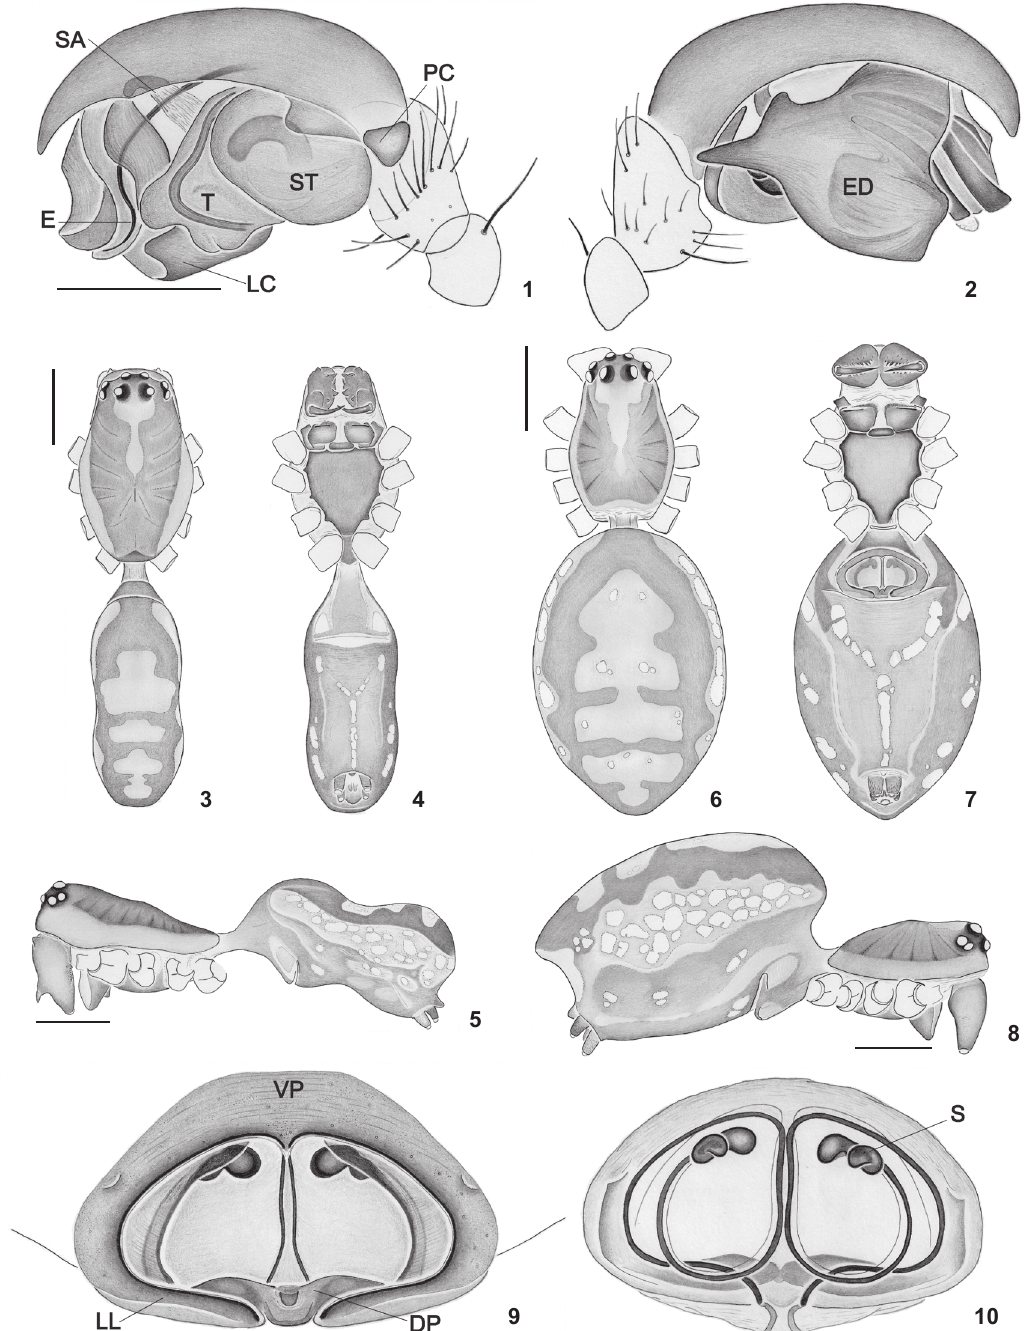
Figures 1-10. Eurymorion triunfo sp. nov. : (1-2) Male palpus: (1) ectal view, (2) mesal view; (3-5) male habitus: (3) dorsal view, (4) ventral view, (5) lateral view; (6-8) female habitus: (6) dorsal view, (7) ventral view, (8) lateral view; (9-10) female epygine: (9) ventral view, (10) dorsal view, cleared. (DP) Dorsal plate, (E) embolus, (ED) embolic division, (LC) lamella characteristica, (LL) lateral lobe, (PC) paracymbium, (SA) suprategular apophysis, (S) spermathecae, (ST) subtegulum, (T) tegulum, (VP) ventral plate. Scale lines: (1, 2, 9-10) 0,25 mm, (3- 8) 0,5